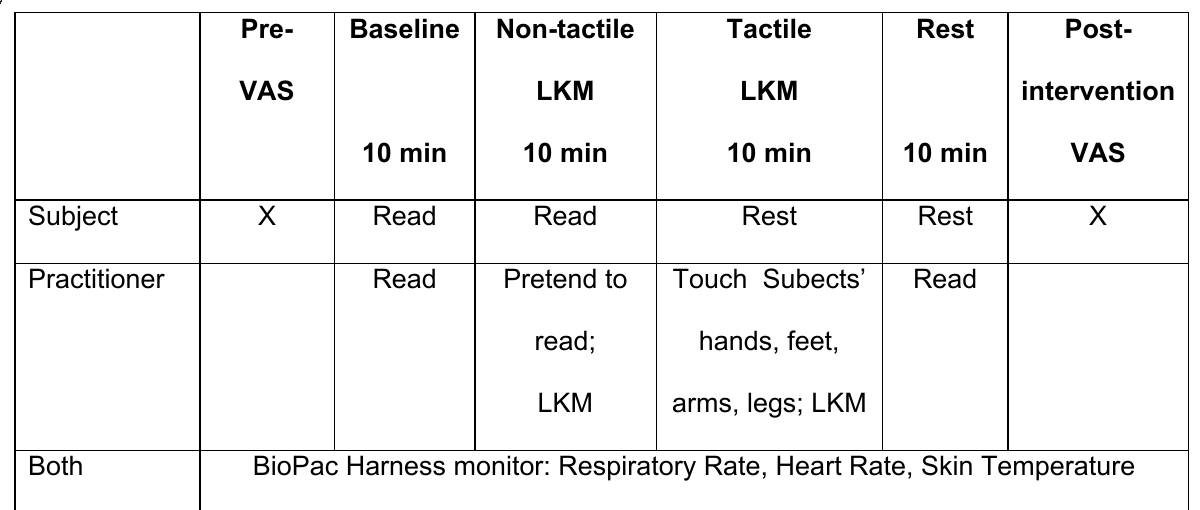
Figure 1 Study Visit . LKM- Lovingkindness meditation VAS- visual analog scales for stress, relaxation, peacefulness NVCC - Non-verbal communication of